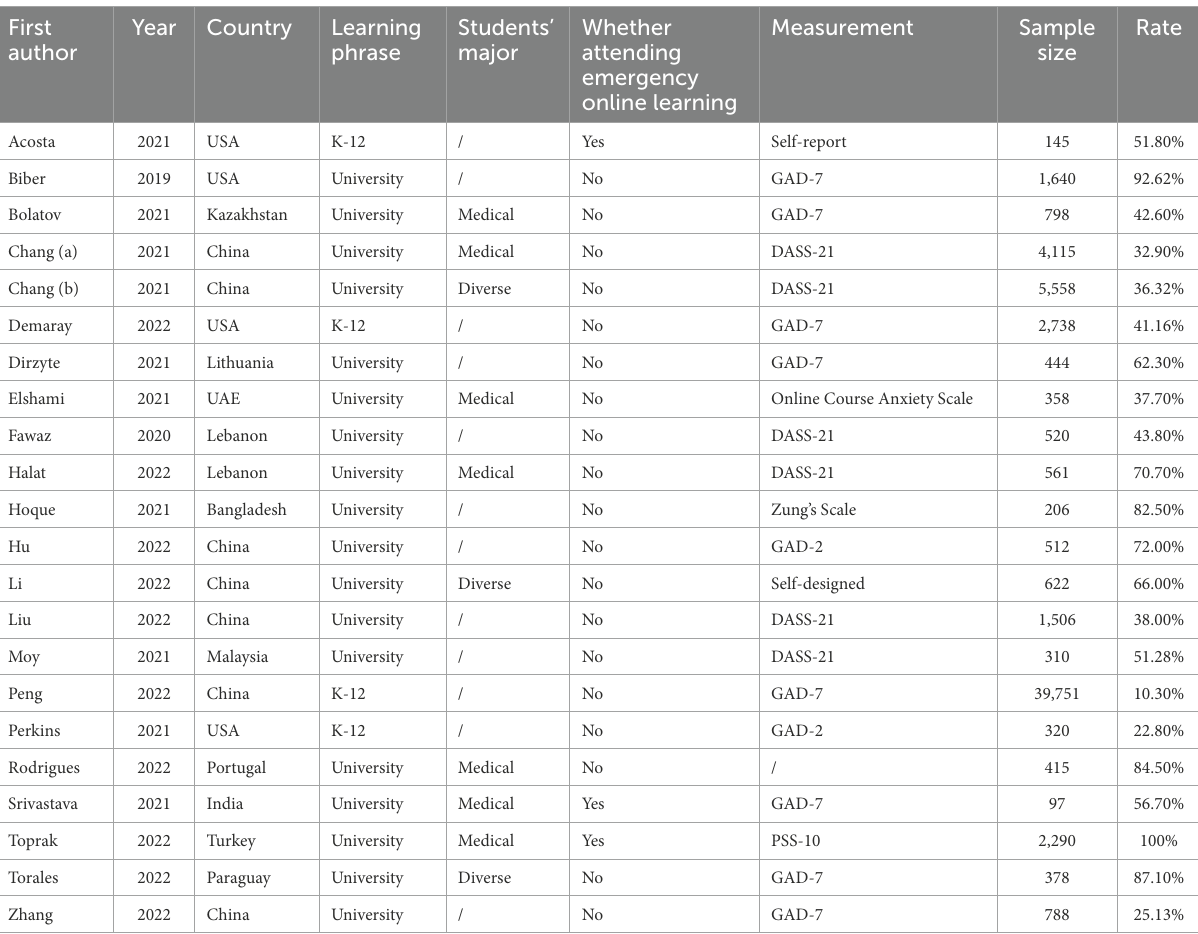
TABLE 1 Summary coding of included anxiety studies (arranged in the alphabetical order of the first